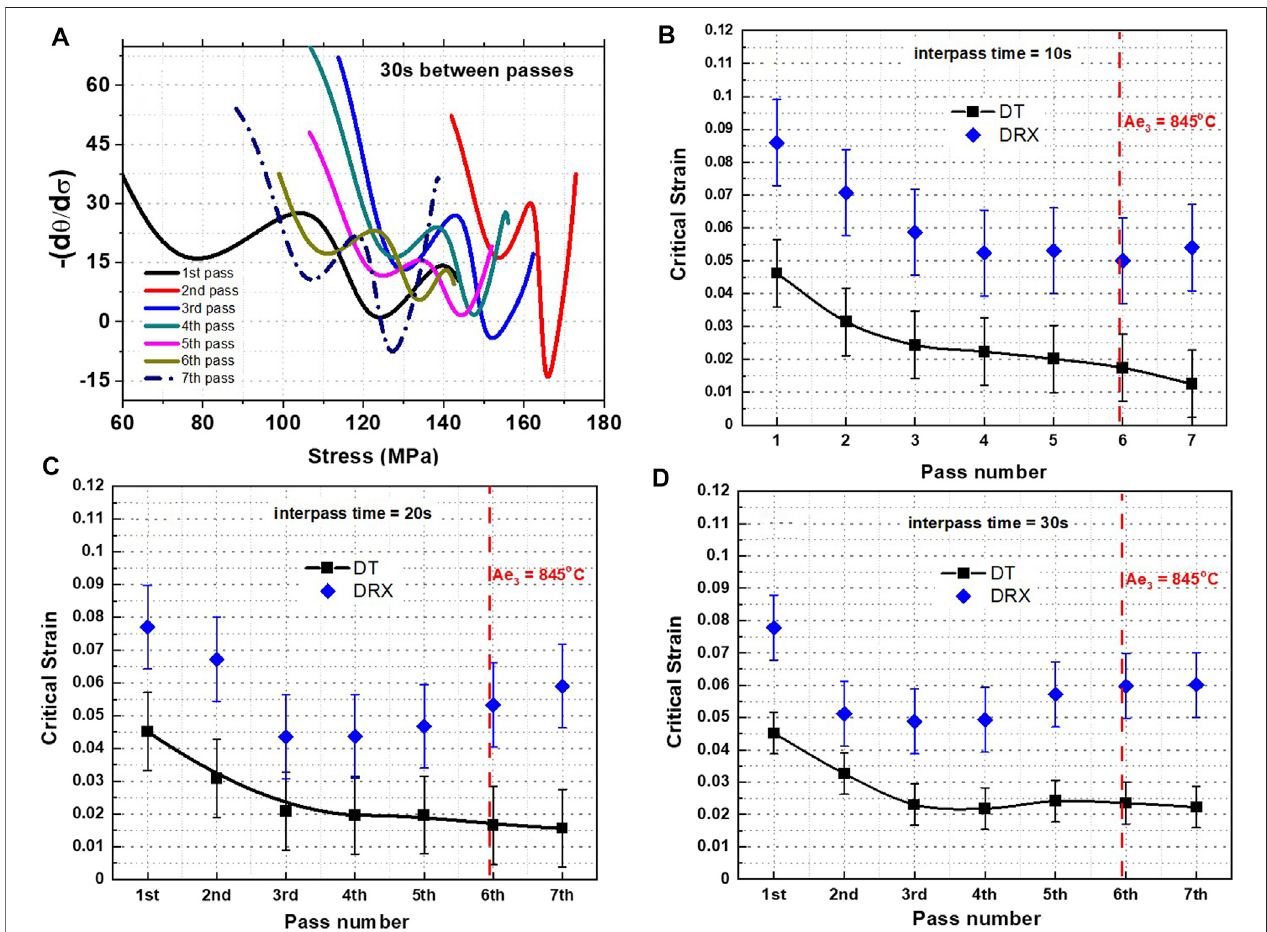
FIGURE 4 | (A) A plot of — (d θ /d σ ) vs. σ curves for 30 s simulation after applying the double differentiation method. The critical strains were then identi fi ed for simulation with interpass times of: (B) 10 s, (C) 20 s and (D) 30